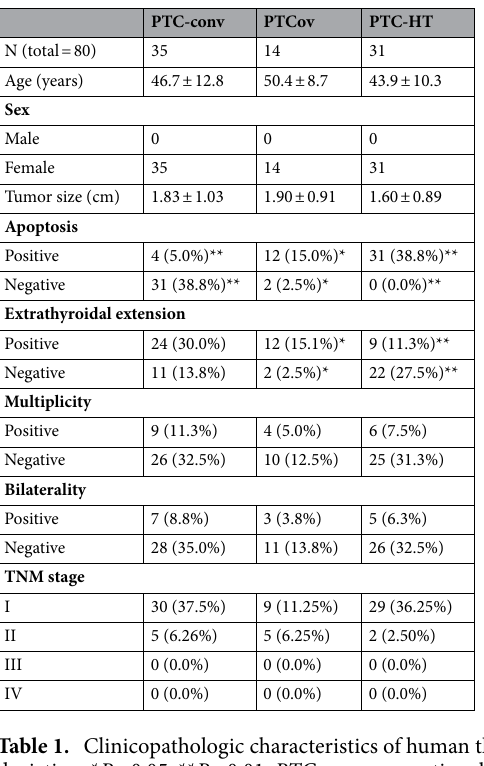
Table 1. Clinicopathologic characteristics of human thyroid cancer cases. Data represent the mean ± standard deviation. * P < 0.05, ** P < 0.01. PTC-conv conventional papillary thyroid carcinoma, PTCov oncocytic variant of PTC, PTC-HT PTC with Hashimoto’s thyroiditis.